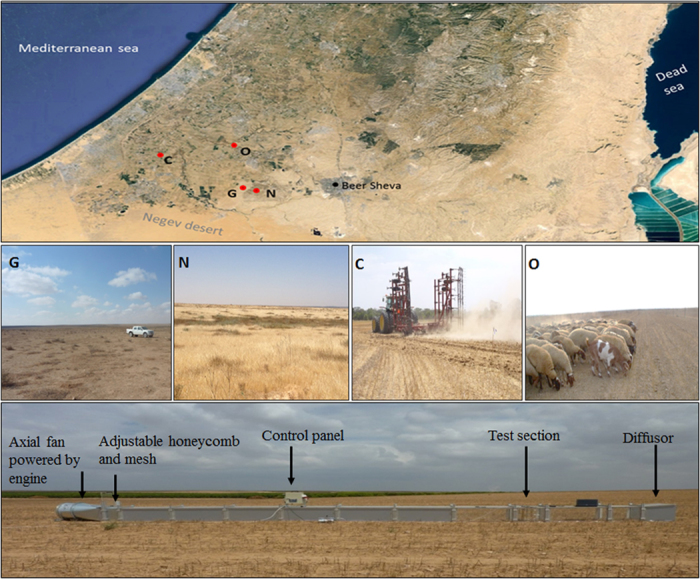
The experimental plots in typical land uses of semi-arid loess soils in the northern Negev: natural reserve (N), grazing area (G), conventional (C) and organic (O) agricultural fields.The annual average rainfall is ~200 mm. Rain events occur mainly between November and March. Winds are mainly western and can exceed 12 m s−1. The soil texture is mostly silt-loam (USDA). The boundary-layer wind tunnel was used for studying the dust emission (see more details in the text). The tunnel segments are presented in the air-push configuration. Instruments were installed in the test section for measuring winds and particle transport. The map produced by ArcGIS 10.0 (www.esri.com). All the photographs were taken in the northwestern Negev (Israel) by I.K.